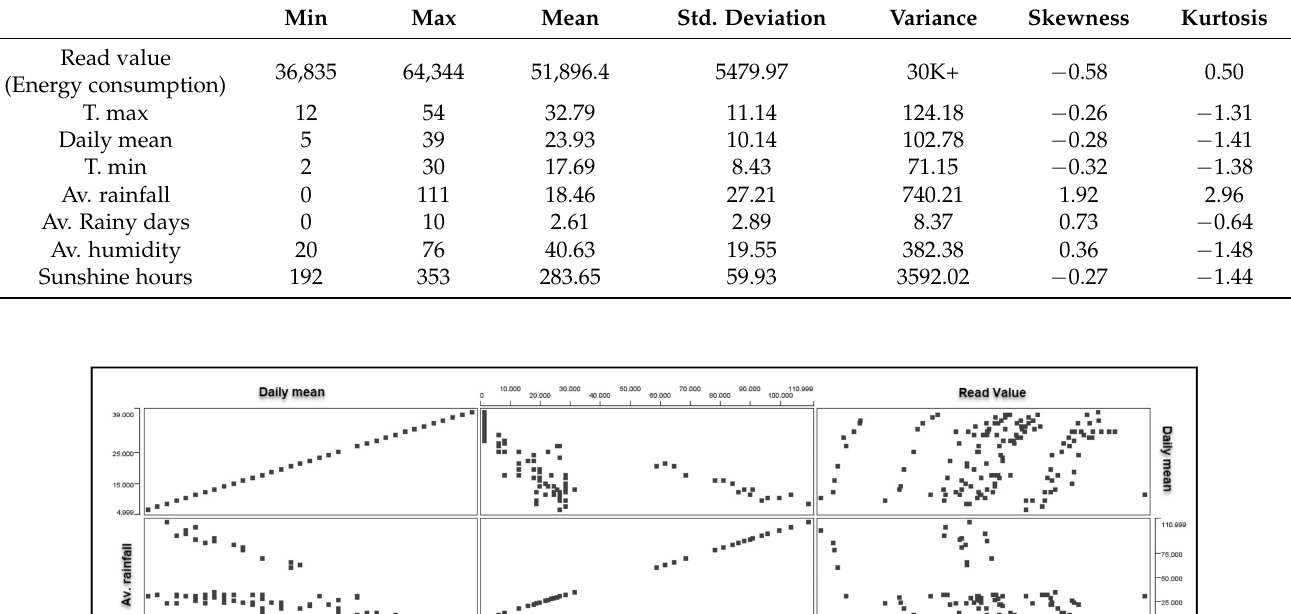
Table 5. Statistical Analysis of Dataset.